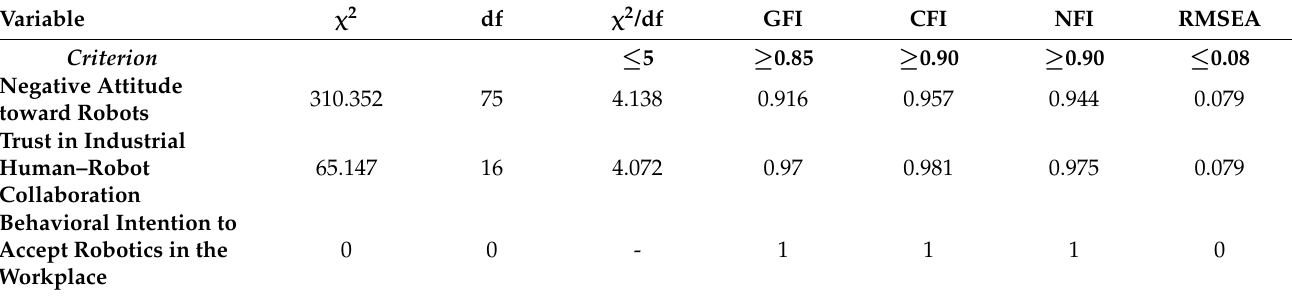
Table 3. CFA Goodness of Fit